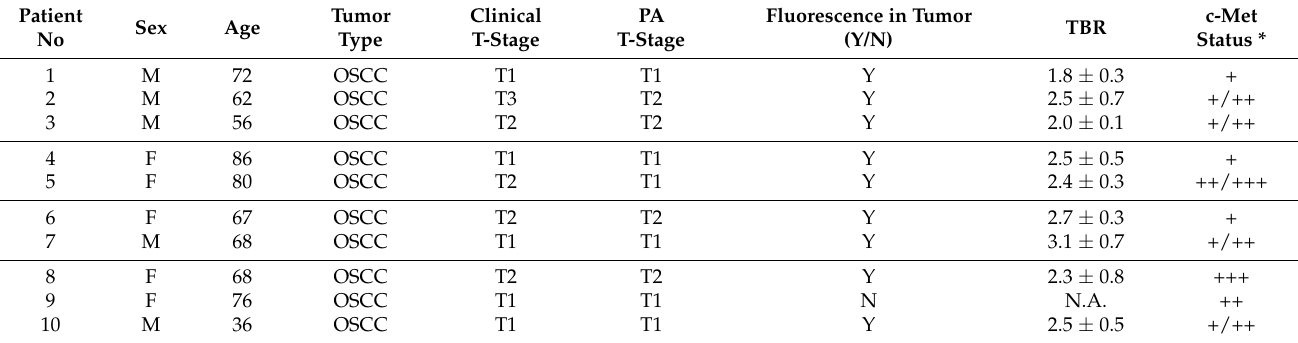
Table 1. Patient